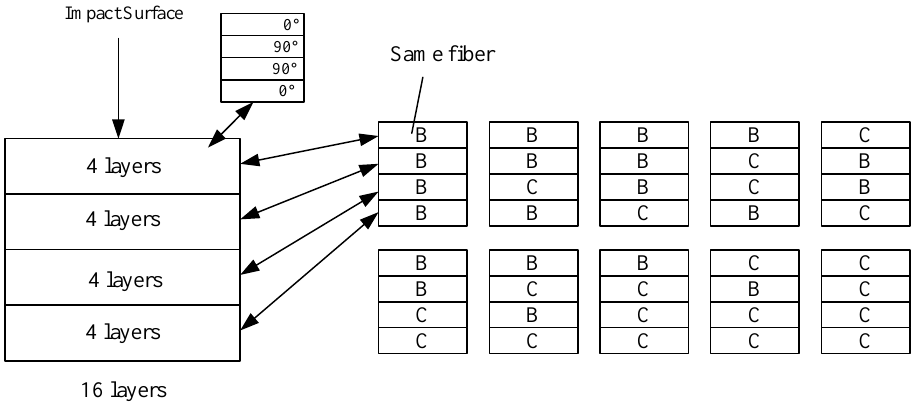
Figure 1. Schematic diagram of low-velocity impact laminate ply.